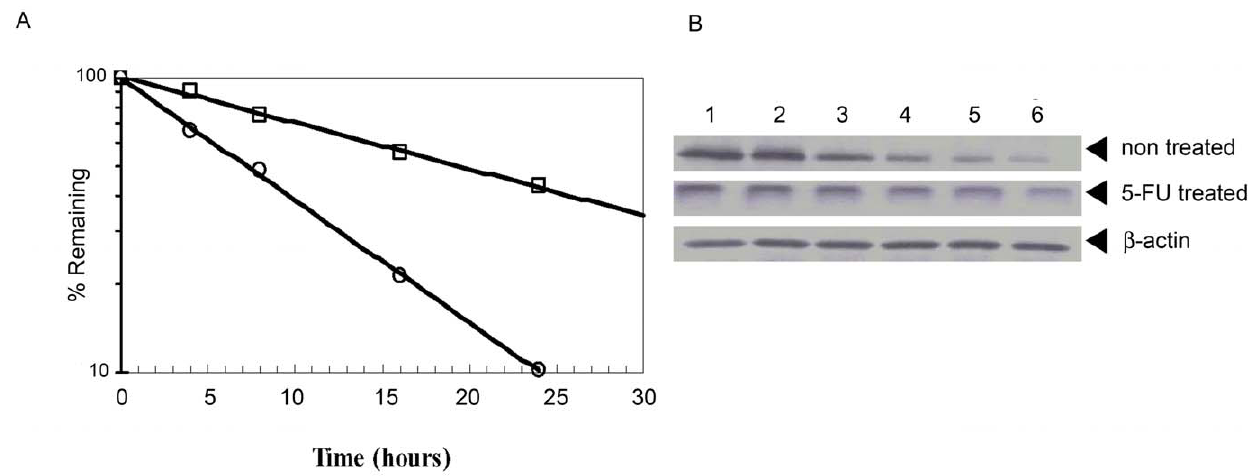
Figure 8. Effect of 5-FU on the stability of TS protein in zebrafish embryos. Healthy embryos at the 1–2 cell stage were treated with 10 m g/ mL cycloheximide and 0.5 m g/mL 5-FU and incubated for another 4, 8, 16, 24 and 36 h. Embryos (n=100) that were untreated or treated with cycloheximide and 5-FU were collected and the total protein was extracted for Western blot analysis as described in the Materials and Methods section. A , TS level in the zebrafish embryo at various time points after 5-FU treatment. TS level in the absence (circles) or presence of 5-FU (box) was analyzed by Western blot and quantified using a Hewlett Packard ScanJet 4P and NIH image 1.51 software. B , Western blot analysis showing the amount of TS at specific times after treatment with cycloheximide. Zebrafish TS embryos were left untreated (panel 1) or treated with 5-FU (panel 2) for 2 h, and 10 m g/mL cycloheximide was added to incubated for another 0 (lane 1), 4 (lane 2), 8 (lane 3), 16 (lane 4), 24 (lane 5) and 36 h (lane 6). Western blots were performed as described in the Materials and Methods